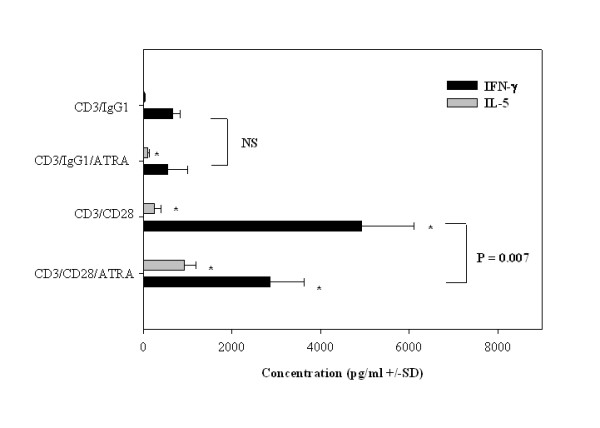
Effects of CD28 co-stimulation on Th1 and Th2 cytokine production by ATRA-treated T cells. IL-5 and IFN-(proteins were quantitated by ELISA in supernatants of purified T cells cultured (1 × 106/ml) with immobilized anti-CD3 mAb (200 ng/ml) ± 1 ug/ml anti-CD28 mAb and treated with ETOH (□) or ATRA 10-7 M (■) for 48 h. The results are expressed as pg/ml (+/- SD) for IFN-(and IL-5. A paired T test was performed on the values derived from three separate experiments as described in the Methods. The P values listed with the brackets compared the significant changes in IFN-γ expression between anti-CD3 mAb +/- CD28 mAb in the presence or absence of ATRA. *P < 0.05 indicates significant differences between anti-CD3 mAb + control IgG1 treated samples and the other experimental groups.